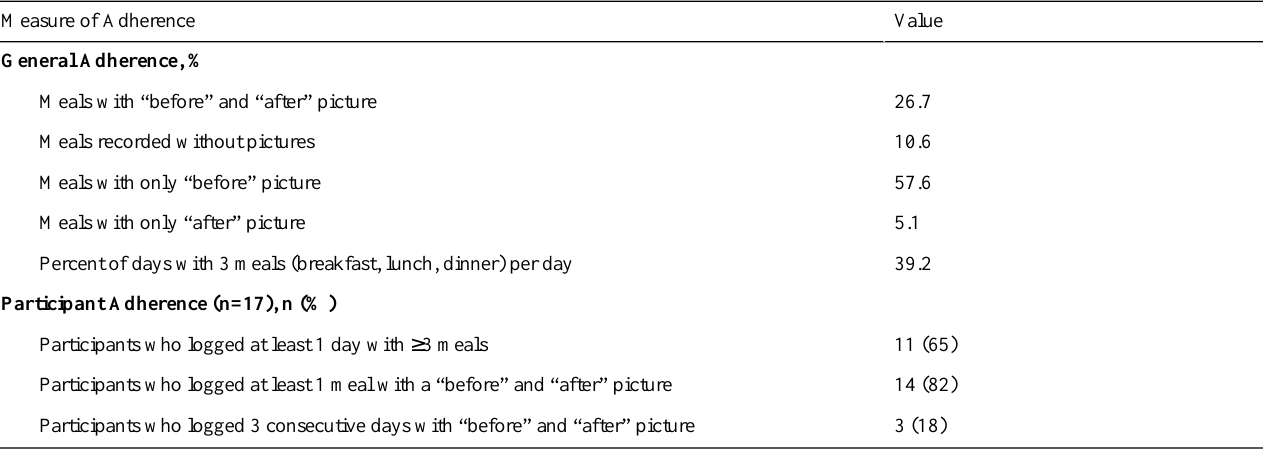
Table 3. Measures of adherence to the digital food record instructions; CV Health and Needs Assessment Qualitative Study. ValueMeasure of